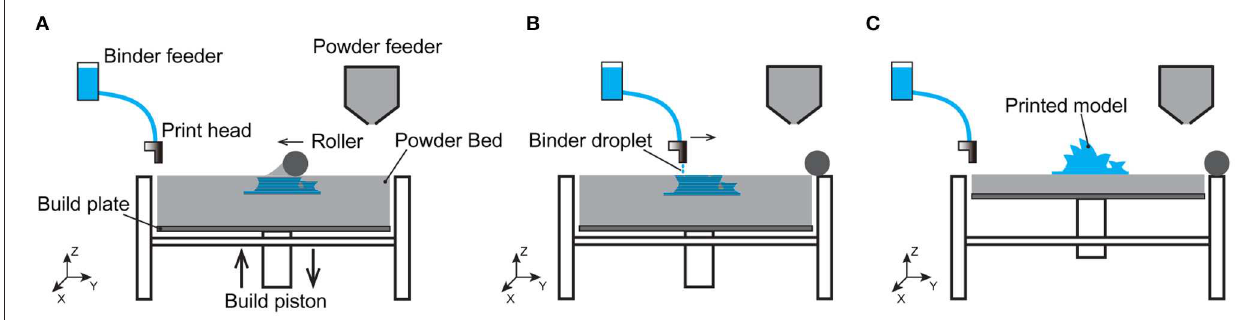
FIGURE 4 | Schematic illustration of the powder-based 3DCP process. (A) Powder spreading, (B) binder droplet deposition, (C) finished “green” sample.